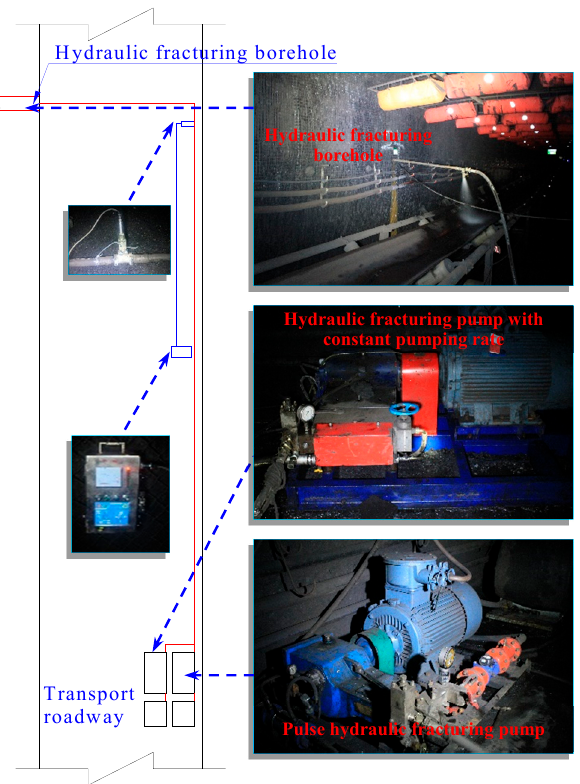
Figure 8. Layout of the hydraulic fracturing equipment.